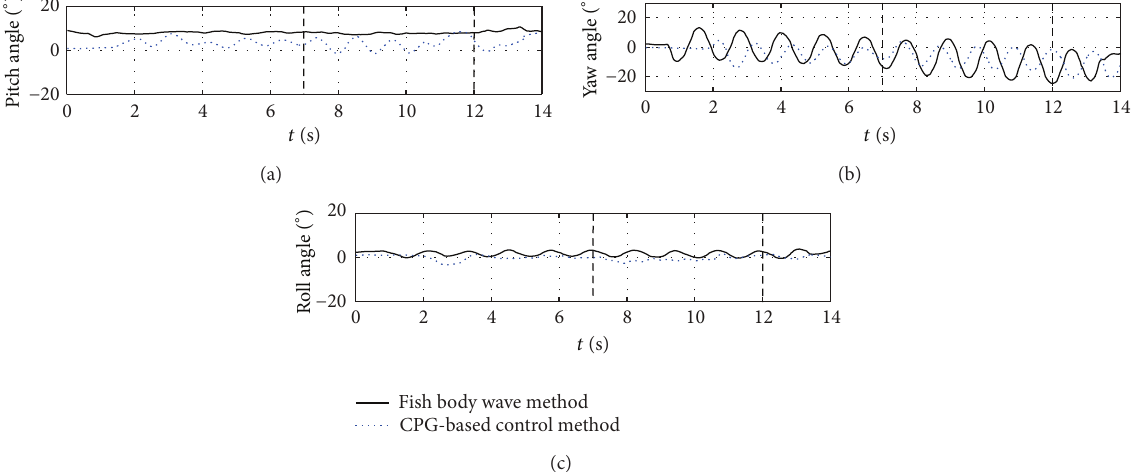
obstacle negotiation or more delicate maneuvers in confined and cluttered